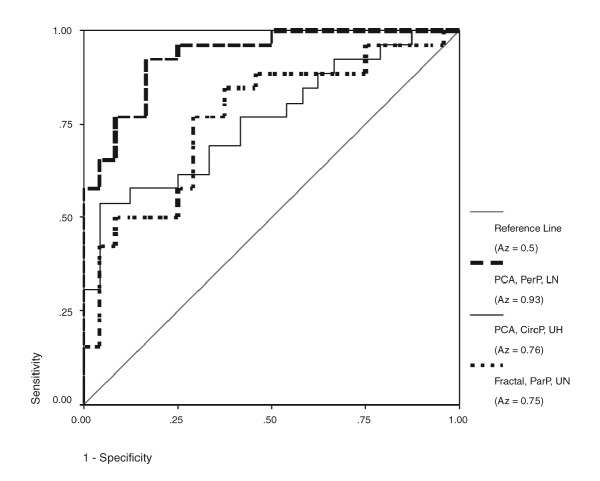
Comparison of ROC curves. Comparison of the ROC curves for the strongest classifier from the combination of (A) PCA analysis of the perpendicular profile (Lower neck region), (B) PCA analysis of the circular profile (Upper head region) and (C) Fractal analysis of any profile (Upper neck region).